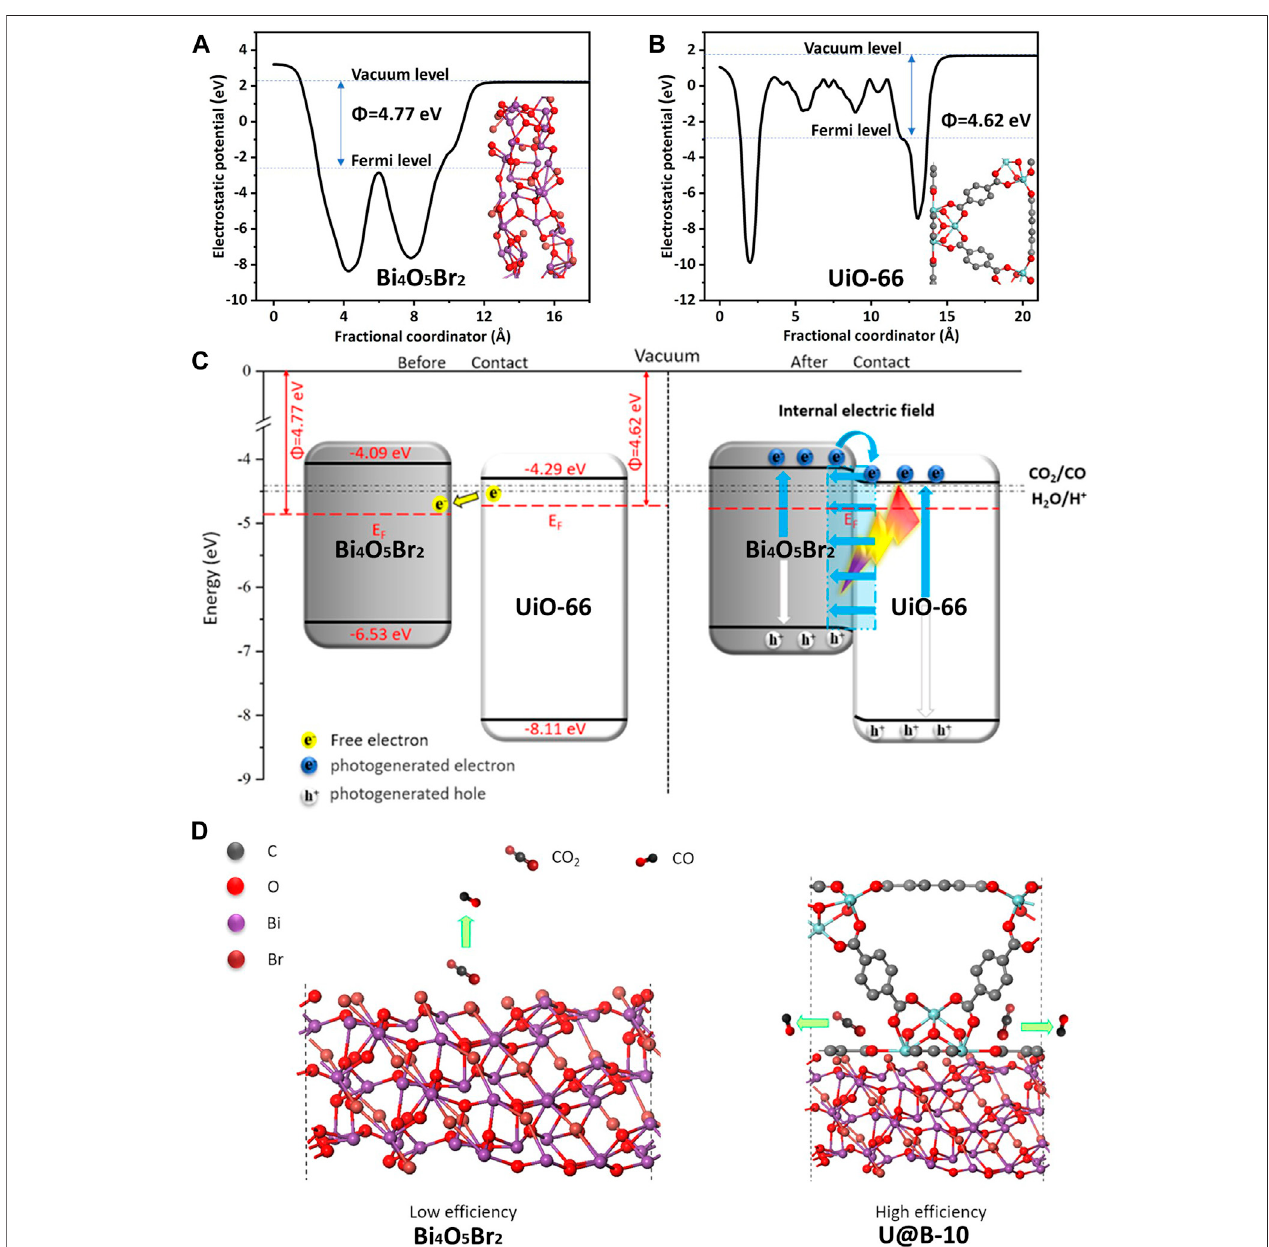
FIGURE 7 | The calculated work functions (A) (11-3) plane of Bi 4 O 5 Br 2 and (B) (100) plane of UiO-66; (C,D) the proposed photocatalytic mechanism of UiO-66/ Bi 4 O 5 Br 2